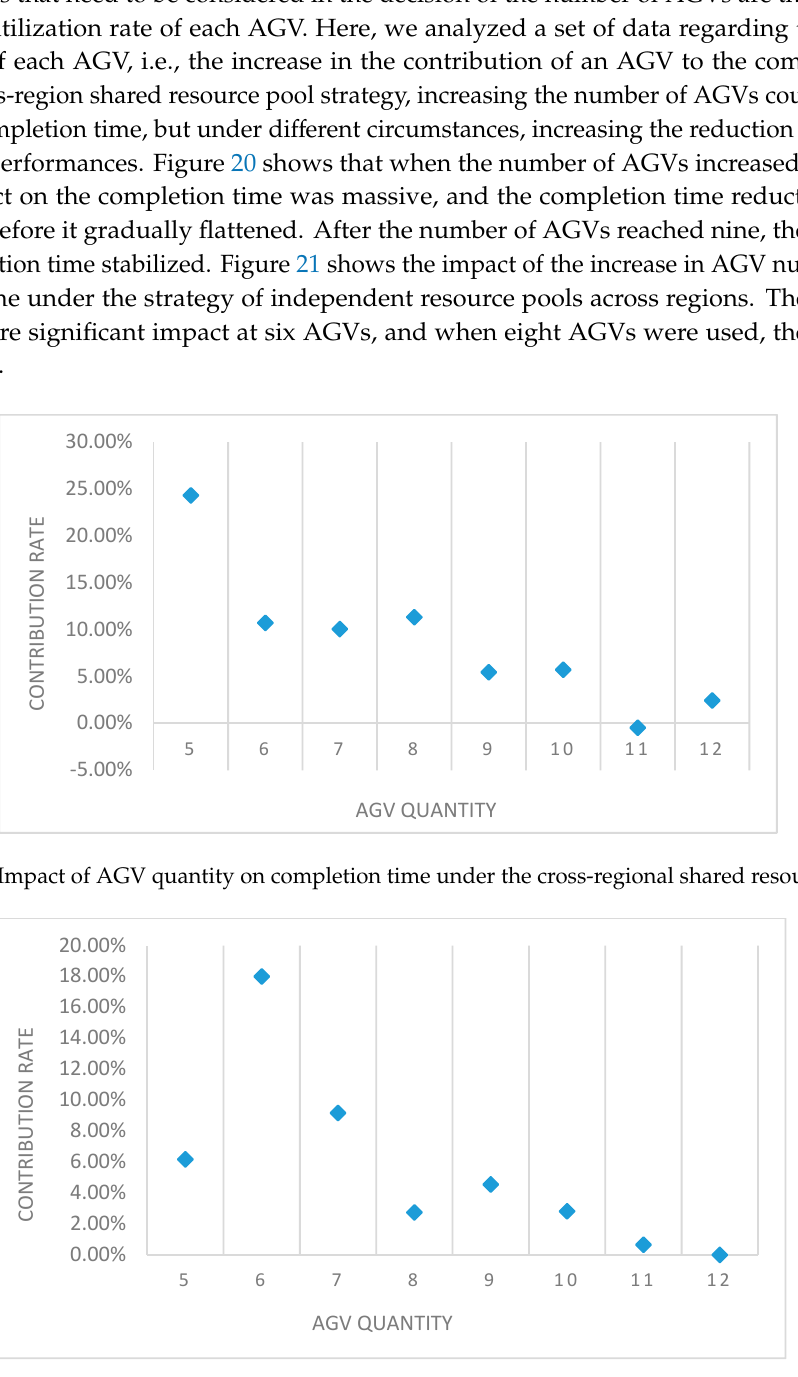
Figure 21. Impact of AGV quantity on completion time under a cross-regional independent resource pool.